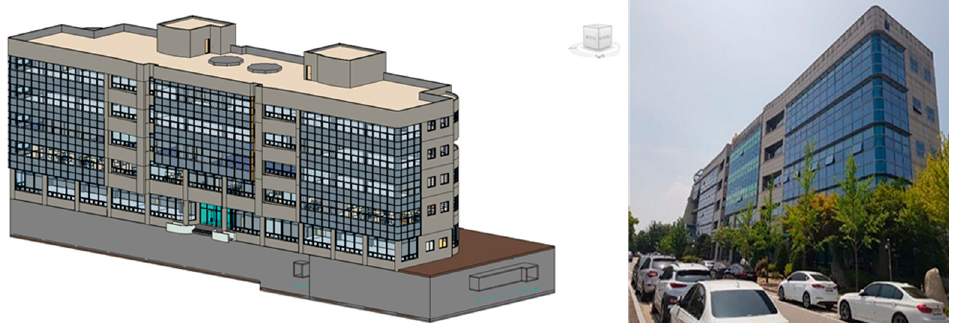
Figure 13. BIM data of actual building used for the case study.